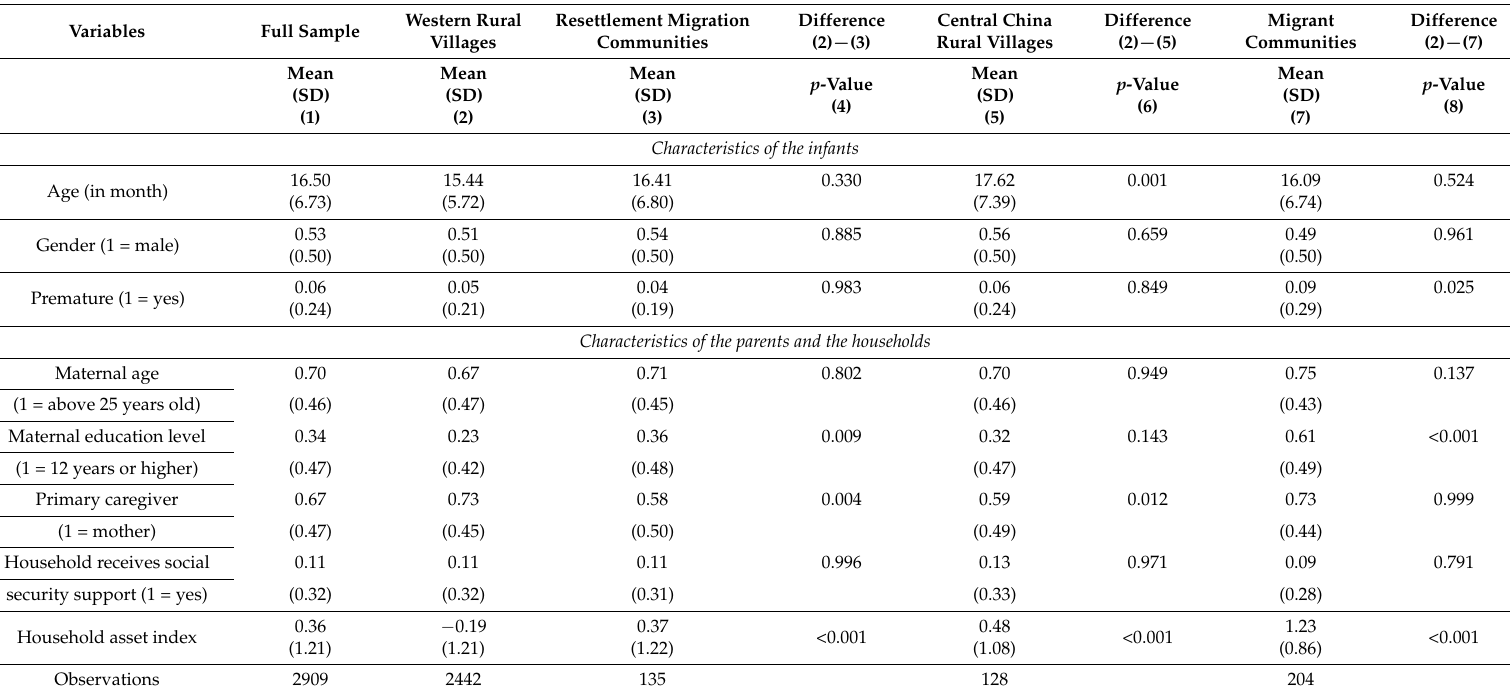
Table 2. Summary